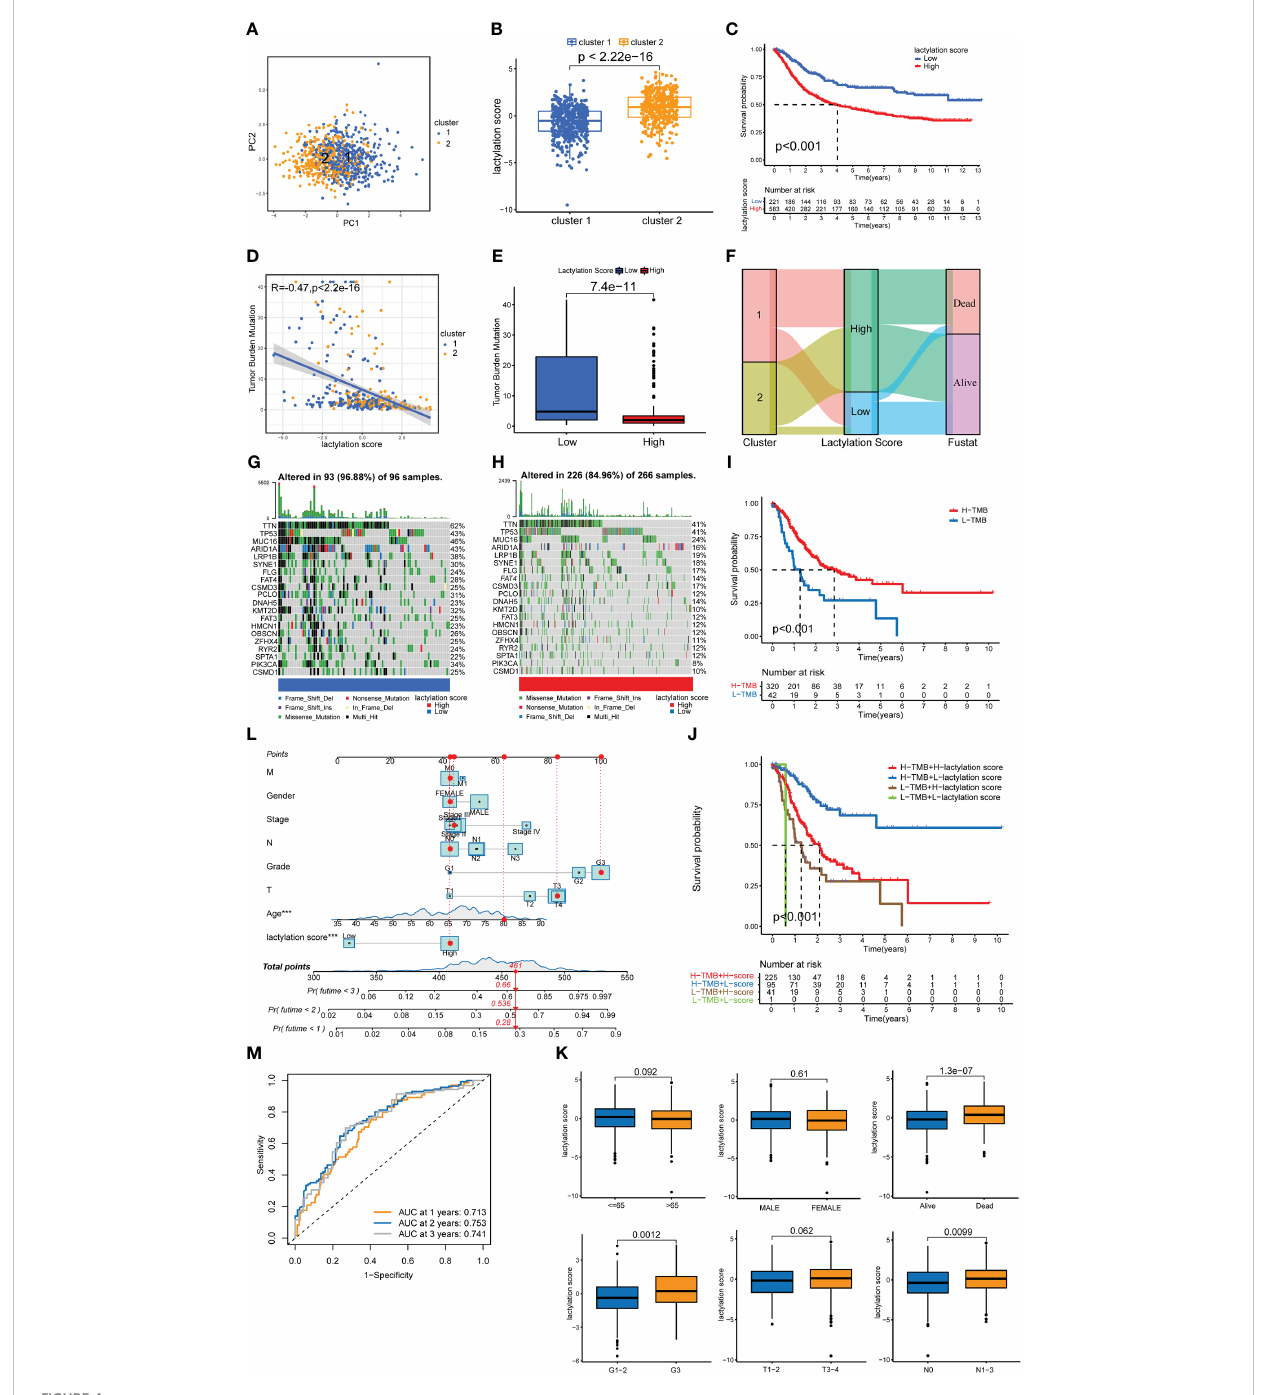
FIGURE 4 lactylation score model. (A) PCA of lactylation-related genes. (B) Lactylation scores of GC types. (C) Kaplan – Meier survival curve of the high- and low-lactylation-score groups. (D) Spearman correlation analysis of the lactylation score and immune cells. (E) UBQLN4 expression in the high- and low-lactylation-score groups. (F) Sankey plot of GC clusters, lactylation score, and patient survival. (G) Waterfall plot of mutation frequencies in the low-lactylation-score group. (H) Waterfall plot of mutation frequencies in the high-lactylation-score group. (I) Kaplan – Meier survival curve of the high-tumor-mutation-burden group and the low-tumor-mutation-burden group. (J) Joint survival analysis was performed in the high and low- tumor-mutation-burden groups and the high- and low-lactylation-score groups. (K) The age, sex, survival, grade, T stage, and N stage of patients in the high- and low-lactylation-score groups. (L) Nomogram of the lactylation score and clinical information. ***p<0.001 (M) AUC of the lactylation score